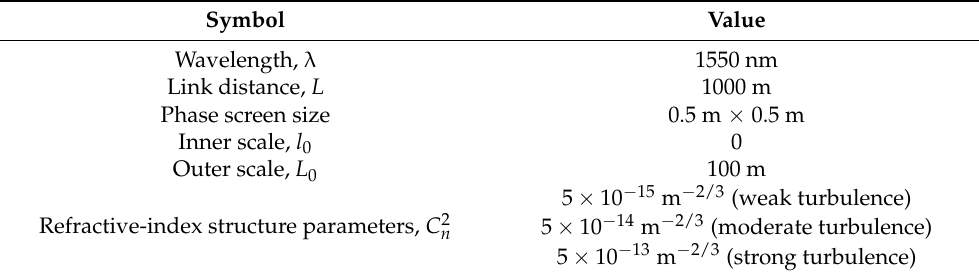
Table 1. Simulation parameter